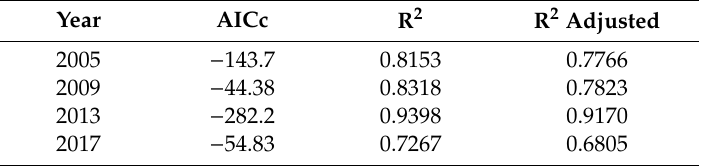
Figure 12. Normalized difference drought index (NDDI) geographic weighted regression standardized residuals. Table 6. Normalized difference drought index (NDDI) geographic weighted regression fitting parameters.